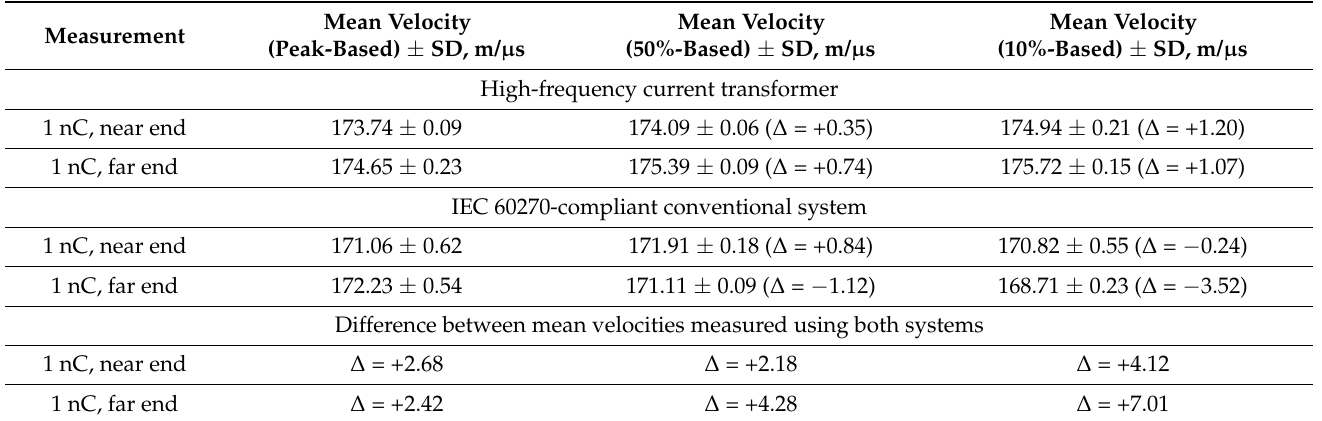
Table 1. Summary of pulse propagation velocity measurement results based on different pulse characteristics, including deviation between mean value compared to peak-based